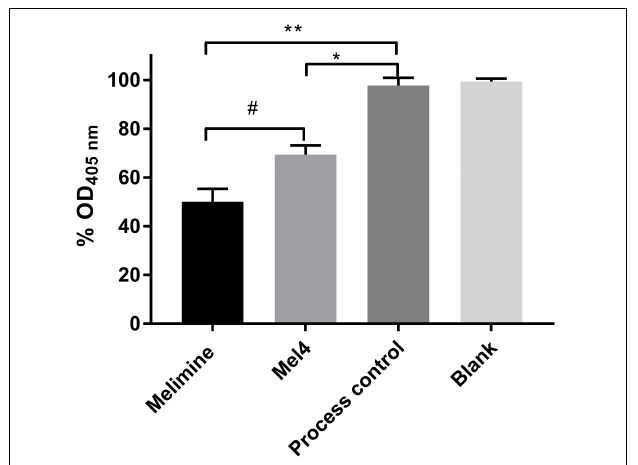
FIGURE 2 | Interaction of surface immobilized peptides with lipopolysaccharides. An LAL assay was used to investigate the interaction of surface immobilized melimine or Mel4 with LPS of Pseudomonas aeruginosa 10. The OD 405nm in (%) dropped significantly after incubation of LPS with peptides attached to glass. * p = 0.005 and ** p < 0.001 compared to process control while # p = 0.004 compared to Mel4.